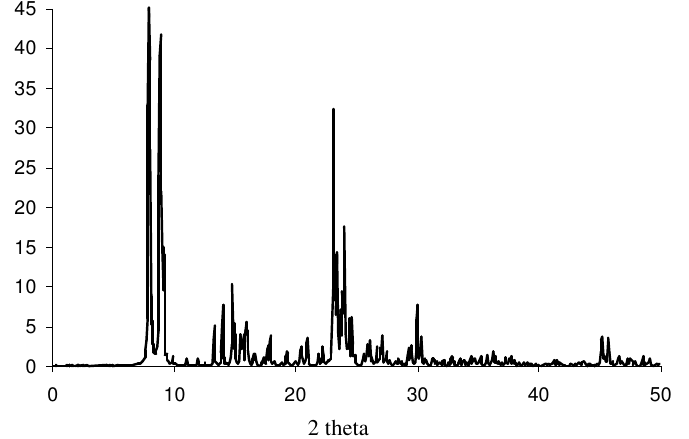
Figure 1. The X-ray diffraction patterns of the ZSM-5 zeolite